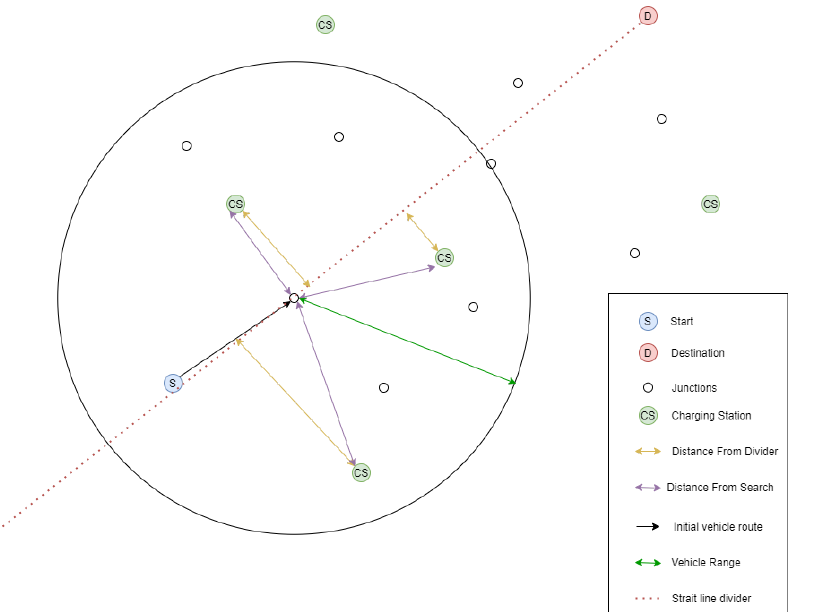
Figure 3. Illustration of our proposed charging station selection